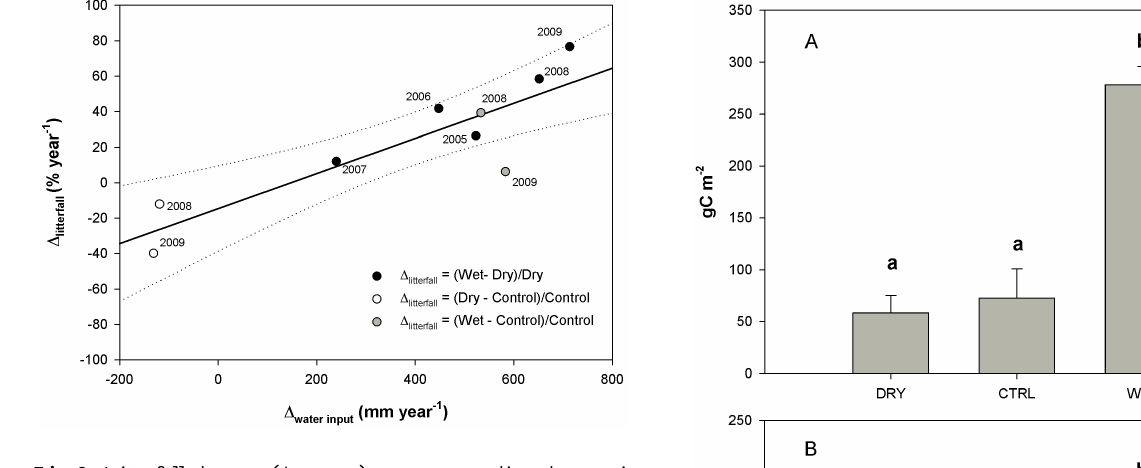
Fig. 2. Litterfall changes ( 1 litterfall ) vs. corresponding changes in annual water inputs ( 1 water input ). Dotted lines represent 95% con- fidence intervals. Regression line is: 1 litter = 0.10* 1 water input –14613. R 2 = 0 . 76, p = 0 . 002. Intercept is not significantly differ- ent from 0 ( p = 0 . 195).